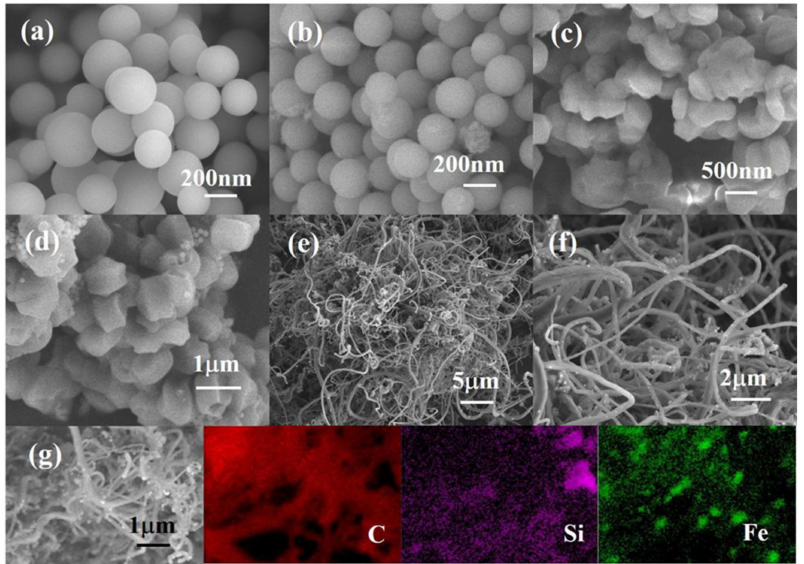
Figure 2. SEM images of SiO 2 nanoparticles (NPs), synthesized by the well-established Stöber method ( a ), reduced Si NPs in the magnesiothermic reduction (MR) process ( b ), SEM images of the